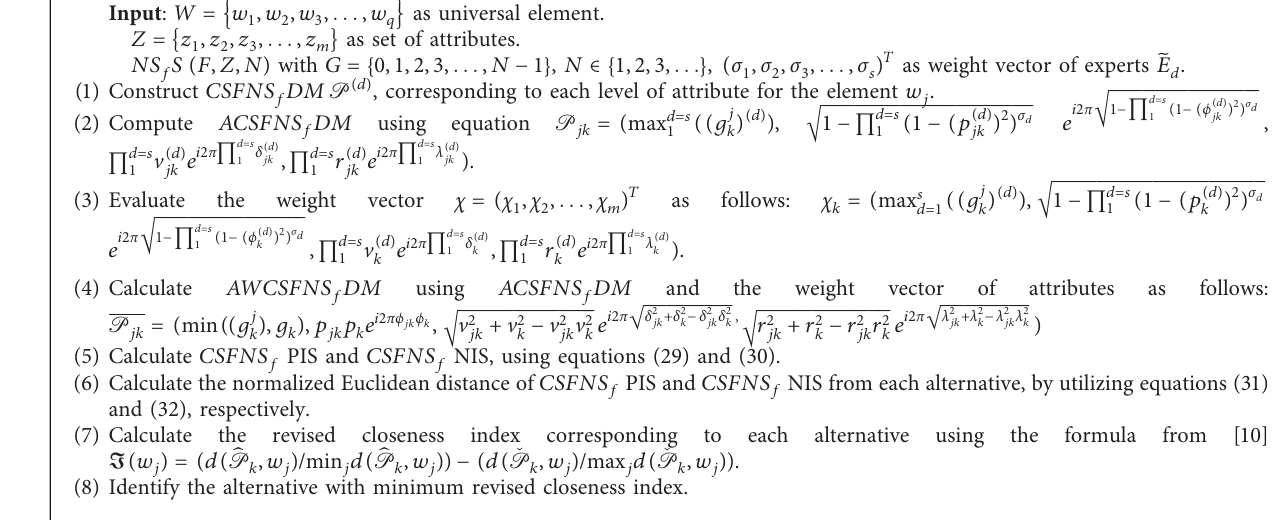
A LGORITHM 1: The algorithm of CSFNS f -TOPSIS method.